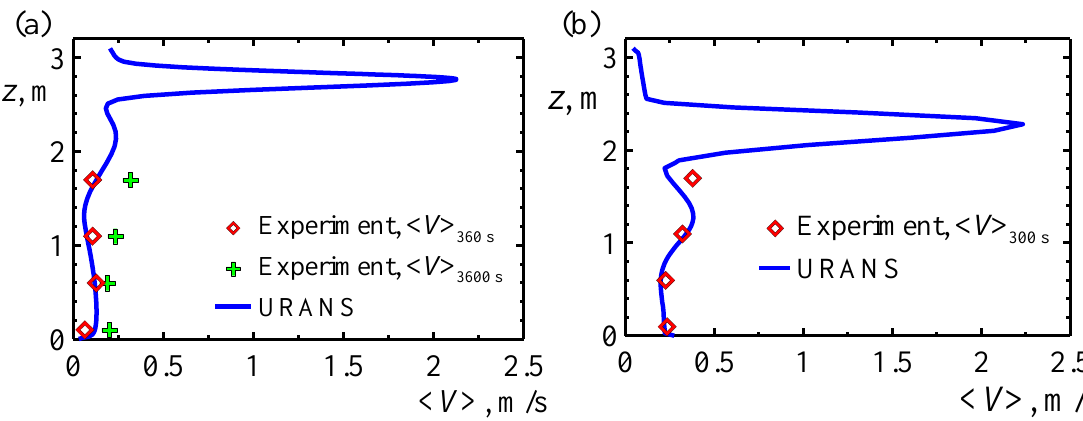
Figure 7. Comparison of the computed mean velocity profile with the experimental data, ( a ) θ = 25°, case #2, and ( b ) θ = 45°, case #3.